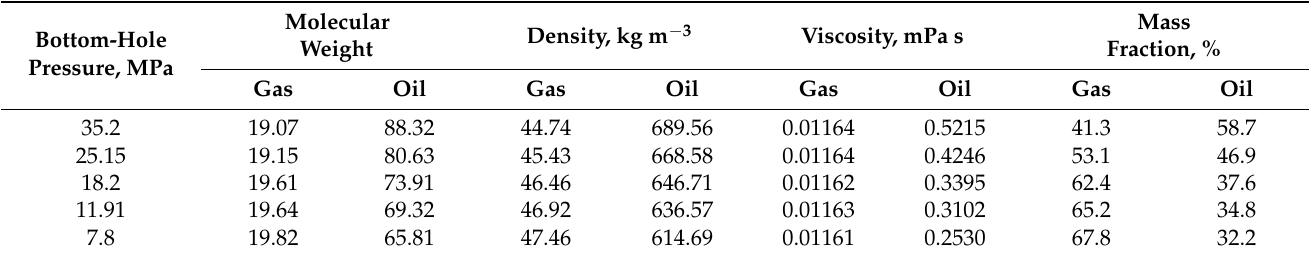
Table 5. Physical parameters of wellhead produced fluid in the gas reservoir.